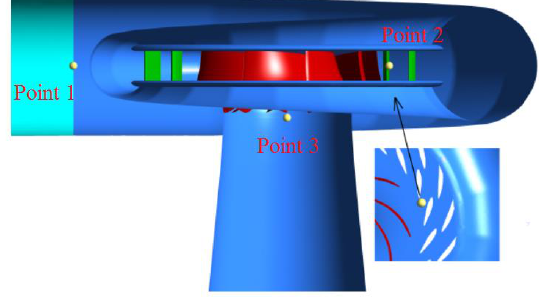
Figure 8. Measuring points of static pressure in the passage.